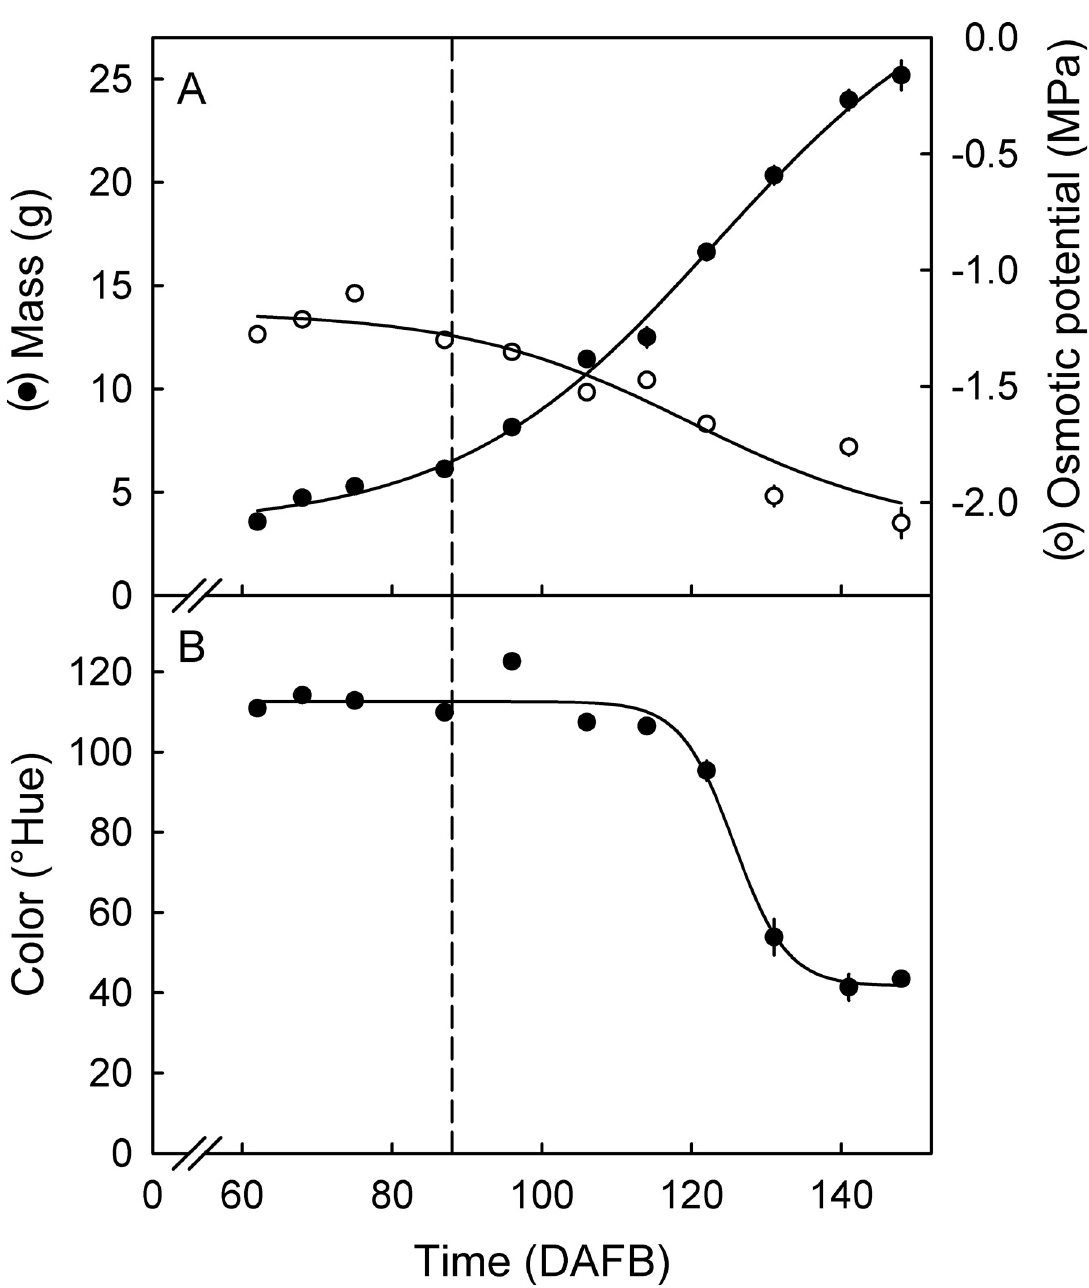
Fig 1. Fruit mass, expressed fruit juice osmotic potential (A) and fruit skin color (B) of developing European plum. Fruit skin color is indexed as a change in Hue angle. The vertical dashed line indicates the transition between stage II and stage III. Time ( x -axis) is in days after full bloom (DAFB). Data represent means ±